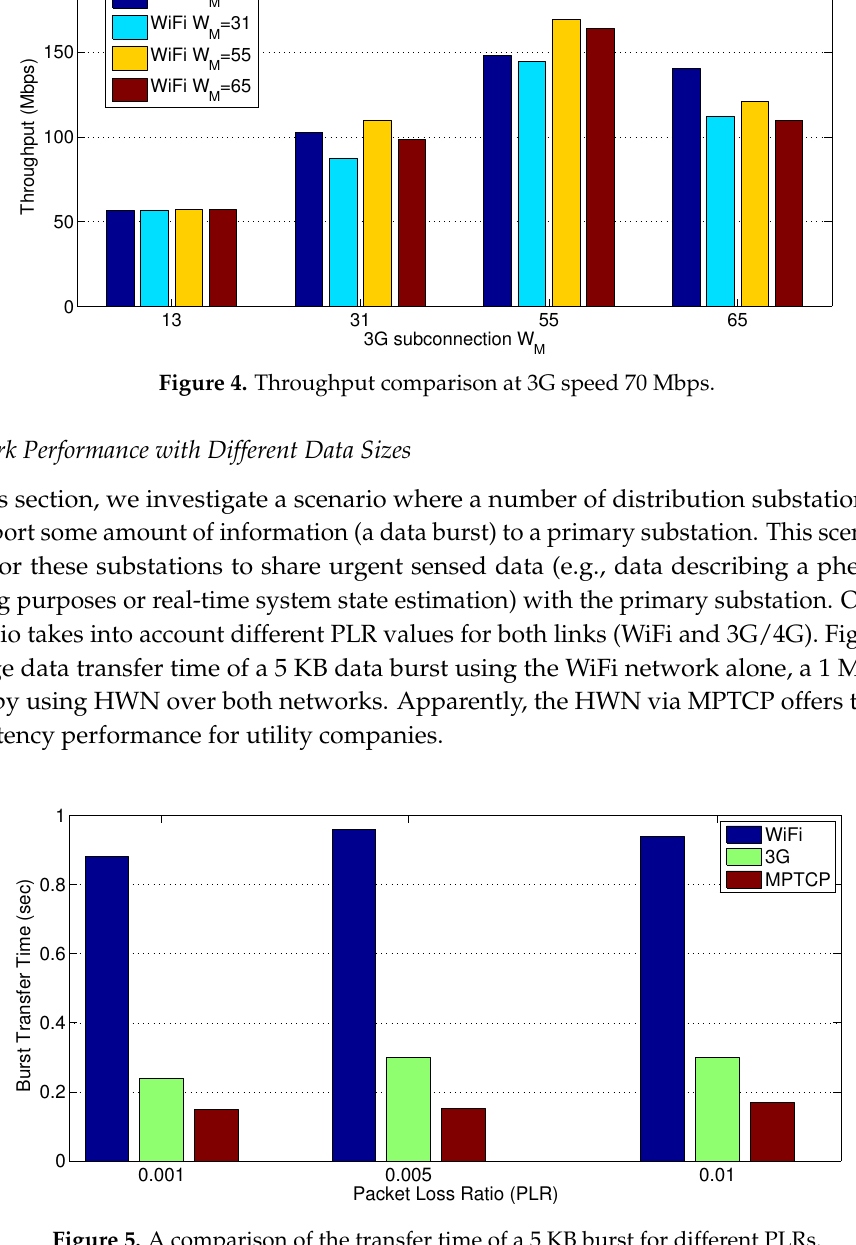
Figure 5. A comparison of the transfer time of a 5 KB burst for different